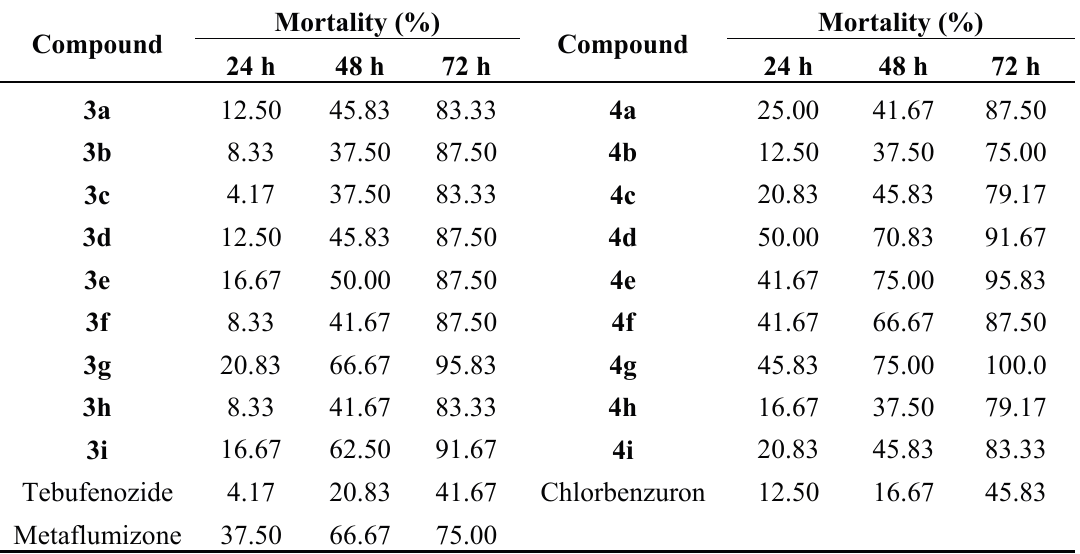
Table 1. Insecticidal activities of the phenylurea derivatives against the third instars larval of beet armyworm (Concentration of 10